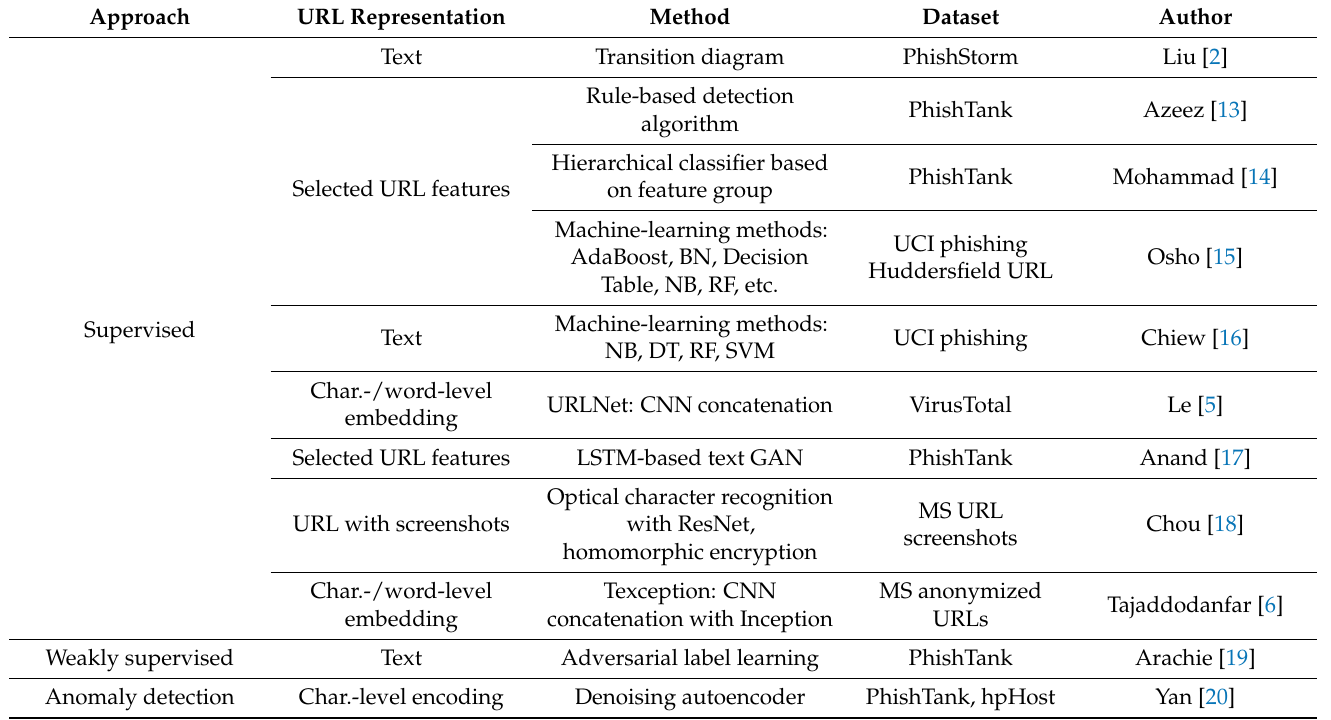
Table 1. Related works on machine-learning-based phishing URL detection with respect to the learning approach and URL